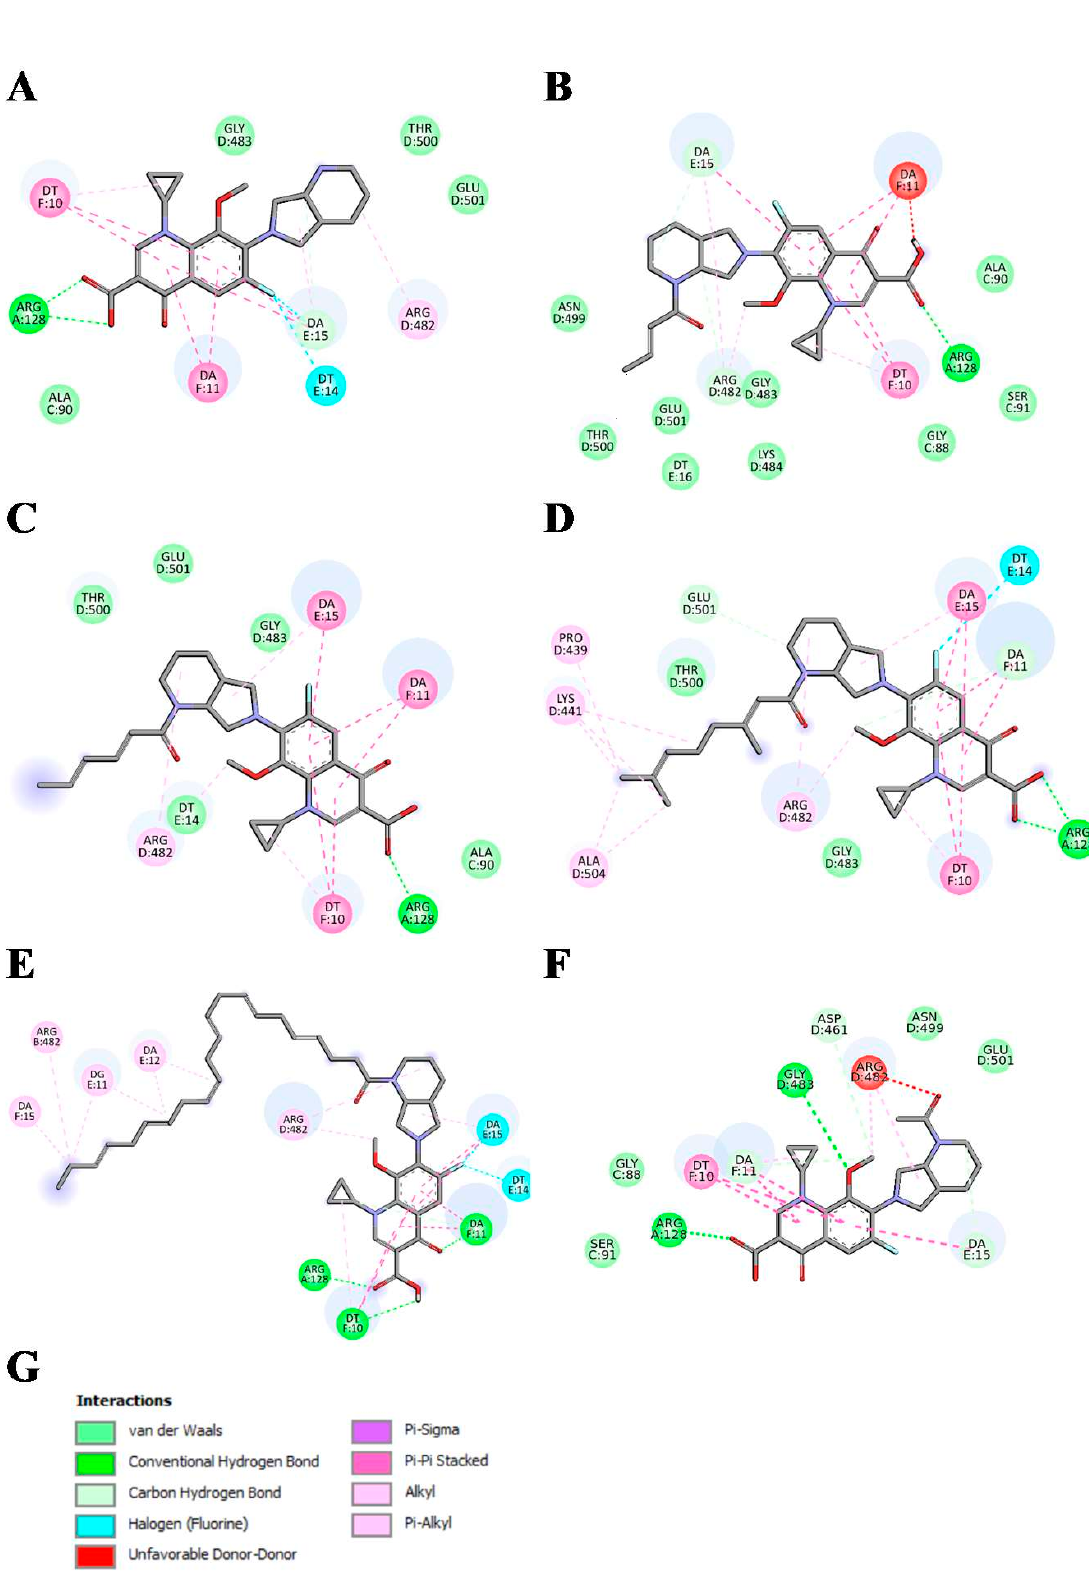
Figure 5. Interactions schemes generated for bound MXF, panel ( A ), and its five derivatives: 1m – 3m , 8m , and 14m , panels ( B – F ), respectively. Colors presenting different interaction types are shown in panel ( G ). Figure generated using BIOVIA Discovery